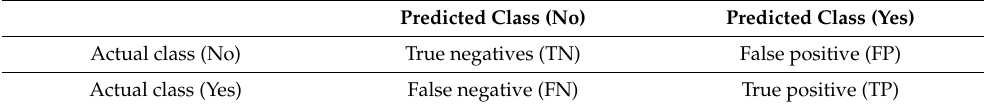
Table 8. Confusion